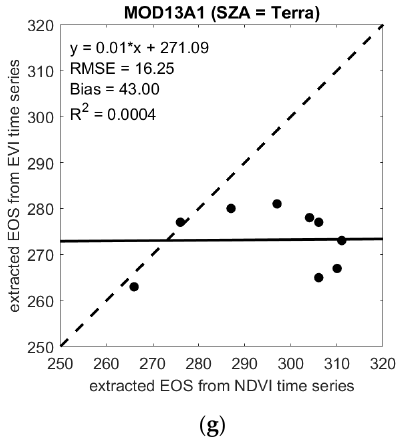
Figure 8. Comparison of EOS derived from the NDVI and EVI time series from 2001 to 2010 when the SZA is ( a ) 0°; ( b ) 15°; ( c ) 30°; ( d ) 45°; ( e ) 60°; ( f ) at local solar noon; and ( g ) dependent on observations of the Terra satellite. ( a – e ) are derived from the simulations, while ( f , g ) are from the MCD43A4 (NBAR) product and the MOD13A1 (VI) product, respectively.